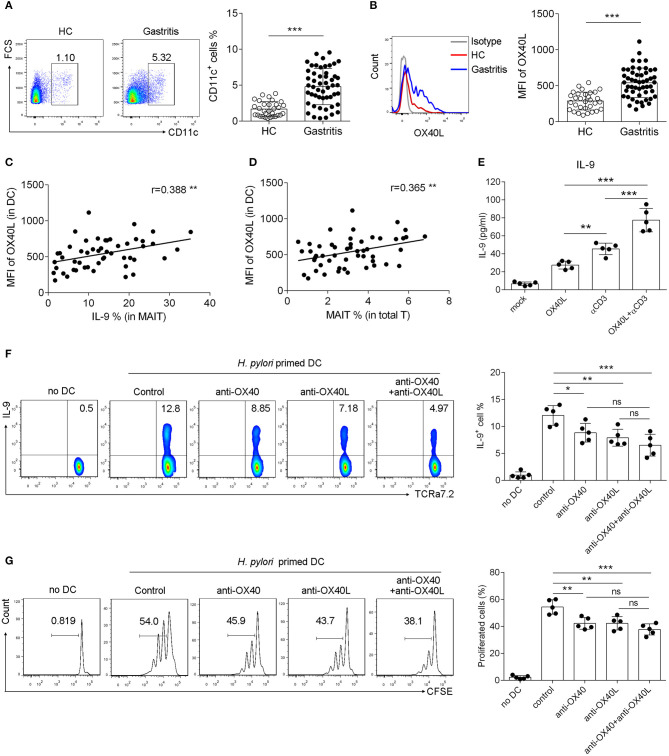
OX40L was induced in DCs and promoted OX40 mediated IL-9 production and proliferation of MAIT cells in H. pylori infection. DCs were isolated from the gastric mucosa of H. pylori-positive patients (n = 51) and healthy donors (n = 35). Flow cytometry was performed to detect the expression of (A) CD11c and (B) OX40L. The correlations of OX40L expression with (C) IL-9 production, and (D) MAIT cells numbers were analyzed, respectively (n = 51). (E) DCs were treated with 10 μg/ml recombinant OX40L protein to activate OX40, and IL-9 secretion was determined by ELISA 24 h later (n = 5). DCs were primed with H. pylori (MOI = 20) to be activated, and co-cultured with MAIT cells in the presence of blocking antibodies against OX40 (10 μg/ml) or OX40L (10 μg/ml). 5 days later, (F) IL-9 production and (G) proliferation of MAIT cells were assessed, respectively (n = 5). Data were from three independent experiments. Unpaired Student's t-test was used to compare the difference between HC and gastritis group. One way ANOVA was performed to compare multiple groups. *P < 0.05; **P < 0.01; ***P < 0.001.